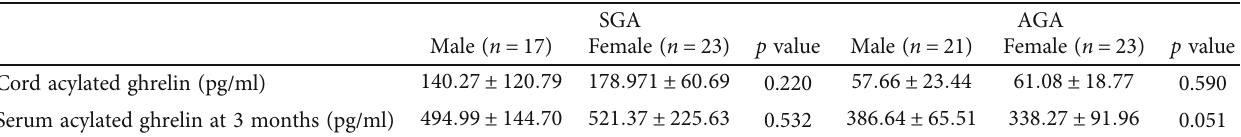
Table 3: E ff ect of gender on acylated ghrelin concentrations in term SGA and AGA